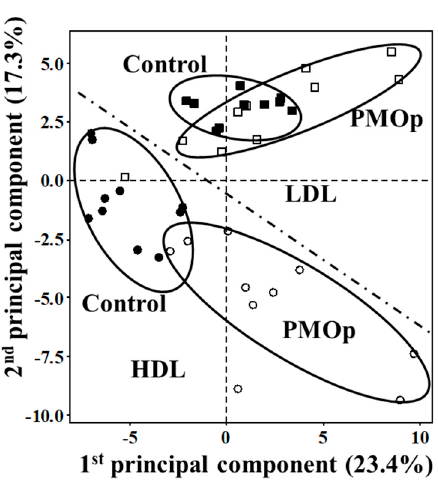
Figure 2. PCA plots representing the differences in lipid profiles of HDL and LDL fractions between patients with PMOp (open symbols) and control (filled symbols).